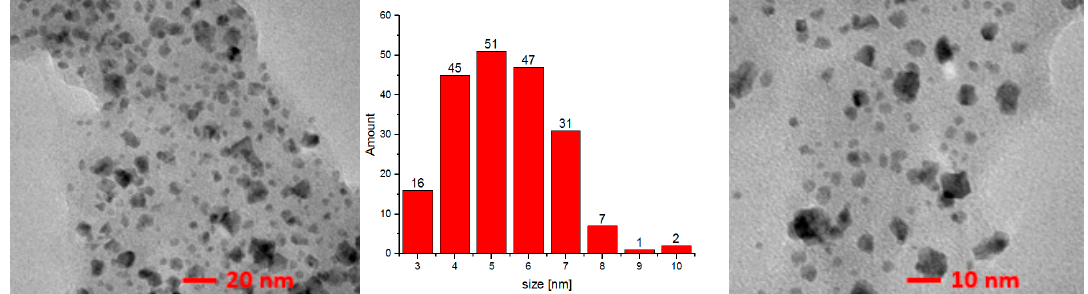
Figure 8. Morphology and size distribution of C3 Pd/DNA.